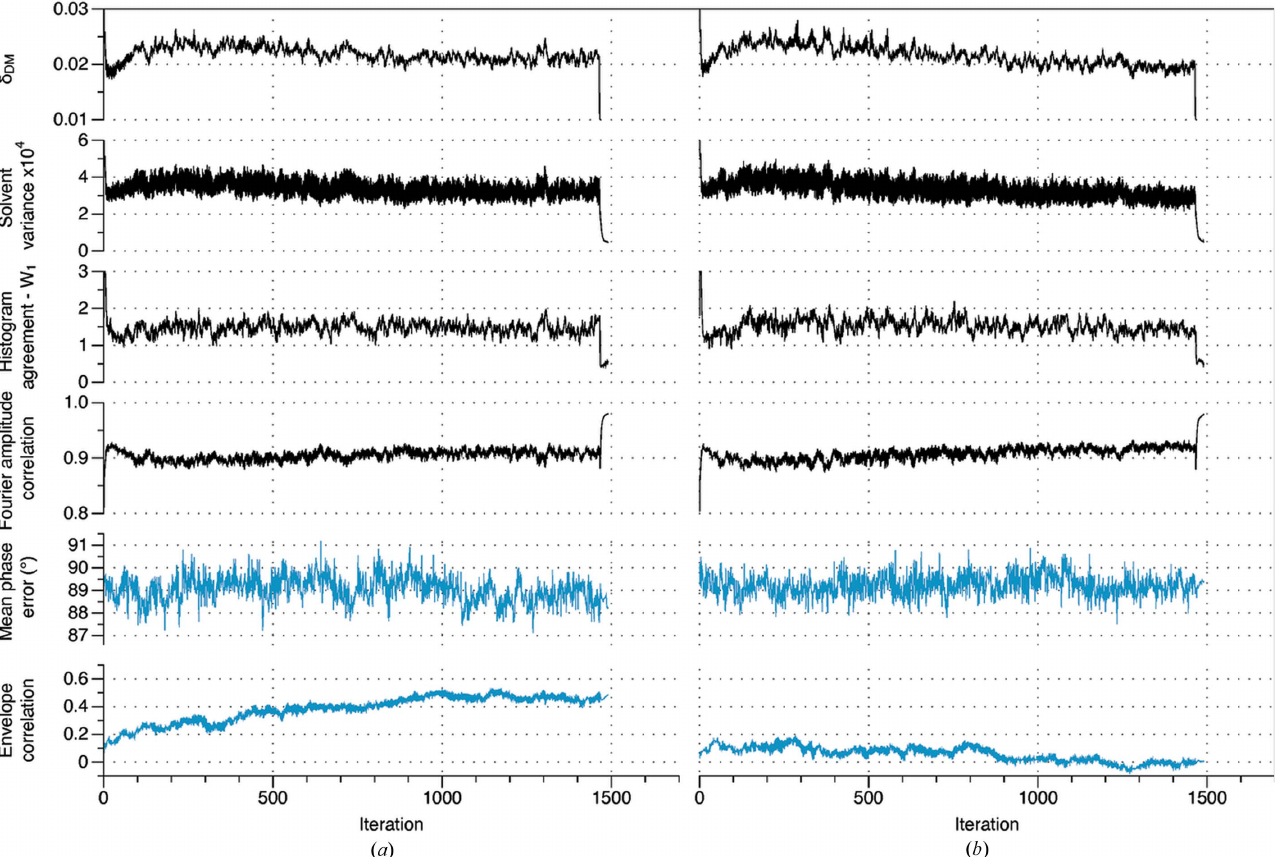
Figure 1 Molecular envelope generation for PDB entry 5b2c (Kubota et al. , 2016) (resolution 2.2 A ˚ , solvent fraction 0.726). ( a ) The trajectory of a successful run. ( b ) The trajectory of an unsuccessful run. The two runs were initiated with different random phase sets. Plotted from top to bottom, as a function of iteration, are the convergence indicator of the DM algorithm ( (cid:3) DM ); the variance in the solvent region; the Wasserstein distance between reconstructed and reference histograms in the protein region; the correlation between reconstructed and measured Fourier amplitudes; the weighted mean absolute difference between reconstructed and model phases; and the correlation between the reconstructed and model envelopes. The metrics that could be followed during determination of an unknown structure are shown in black, while the metrics that assess agreement with the known solution are shown in